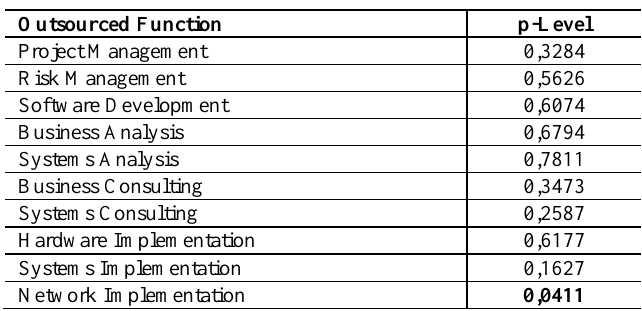
Table 9: Kruskal-Wallis p-values for Type vs Influencing Factors